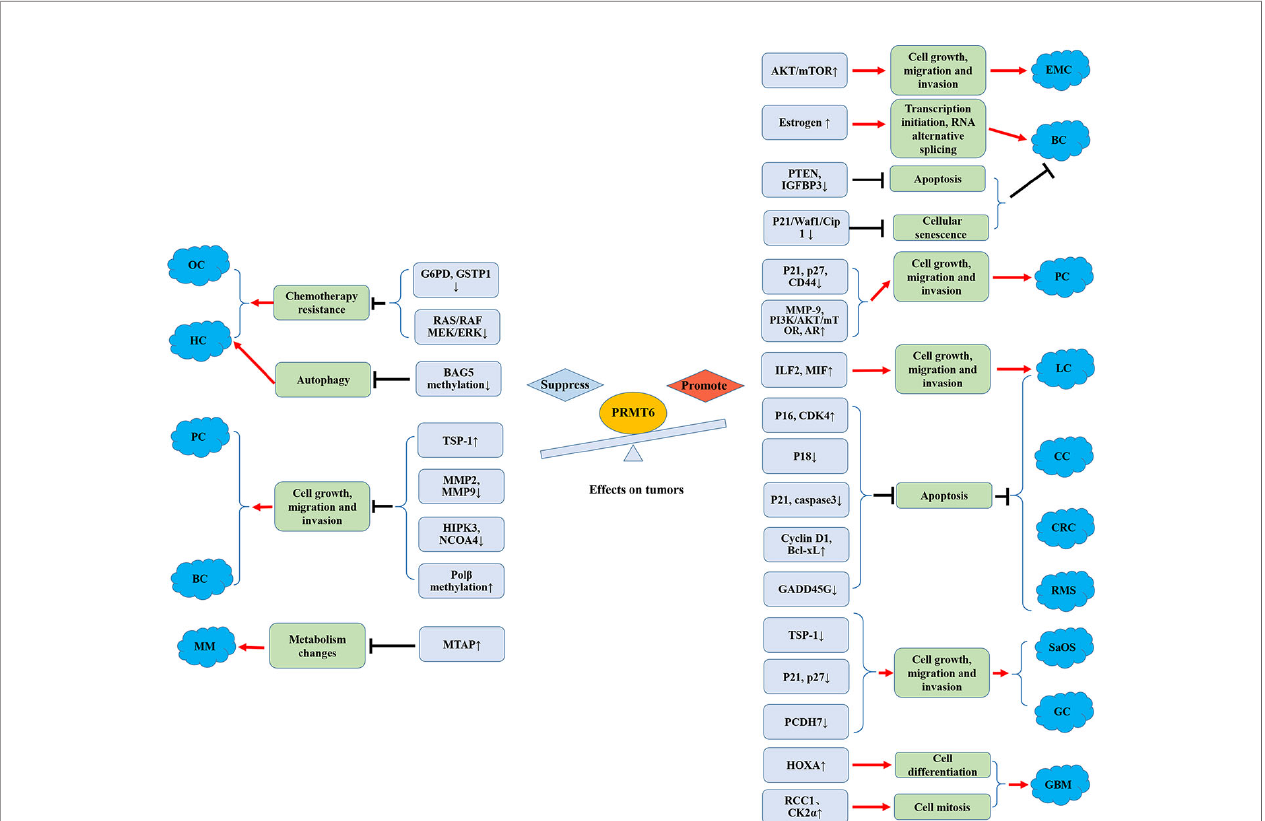
FIGURE 3 | Promoting and suppressing effects of PRMT6 on different cancers. OC, ovarian cancer; HCC, hepatocellular carcinoma; MM, melanoma; PC, prostate cancer; BC, breast cancer; EMC, endometrial carcinoma; CRC, colorectal cancer; SaOS, osteosarcoma; GC, gastric cancer; CC, cervical cancer; LC, lung cancer; RMS, rhabdomyosarcoma; GBM, glioblastoma; AR, androgen receptor; Pol b , DNA polymerase b